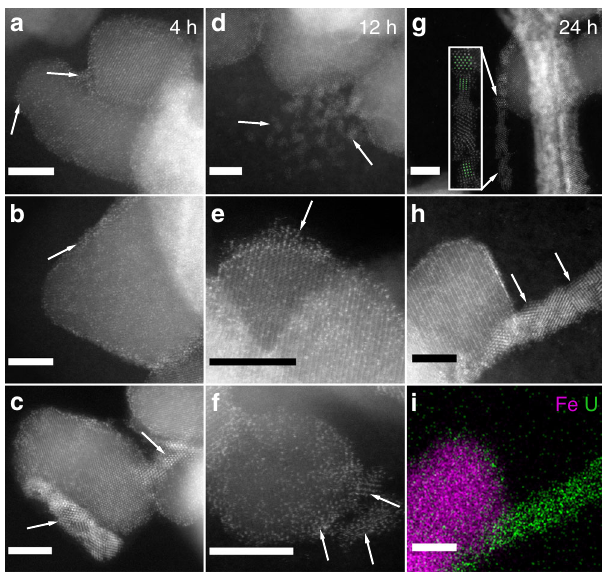
Fig. 2 Scanning transmission electron micrographs of U-magnetite samples. High-angle annular dark- fi eld scanning transmission electron microscopy images of U-magnetite samples were obtained (scale bar 5 nm). a , b 4-h Sample; c : replicate 4-h sample; d – f 12-h sample; g – i 24-h sample. i Energy-dispersive X-ray spectroscopy showing U in green and Fe in magenta. The bright contrast spots on the magnetite surface in a – h are U atoms. Arrows in a and b point to dispersed U atoms on the surface of magnetite nanoparticles or accumulated U atoms on the edge of magnetite nanoparticles; arrows in c point to formed U nanoparticles in a replicate 4-h sample (see Fast Fourier Transform in Fig. 3); arrows in d and f point to formed U nanoparticles on or near the surface of magnetite nanoparticles; the arrow in e points to the accumulation of U atoms along planes in the same orientations as magnetite lattice planes; arrows in h point to individual nanoparticles in a single nanowire that extends from the magnetite surface; inserted image in g simulated UO 2 pattern (in green) for the three nanoparticles contained in the observed nanowire structure and the de fi ned zone axes: from top to bottom, nanoparticles are in the [011], [112], and [001] zone axis. The simulation of the given zone axis of U atoms in green was done using Vesta 50 . (Fig. 2a, b) show aggregates of magnetite nanoparticles with uranium atoms readily identi fi able as bright contrast spots on the surface and prominent accumulation at the particle edges. This observation is consistent with the M 4 edge XANES result, showing that the majority of U (92%) remained as U(VI) after 4 h. Therefore, no signi fi cant solid-phase uranium oxide products would be expected. In contrast, observation of the 12-h sample